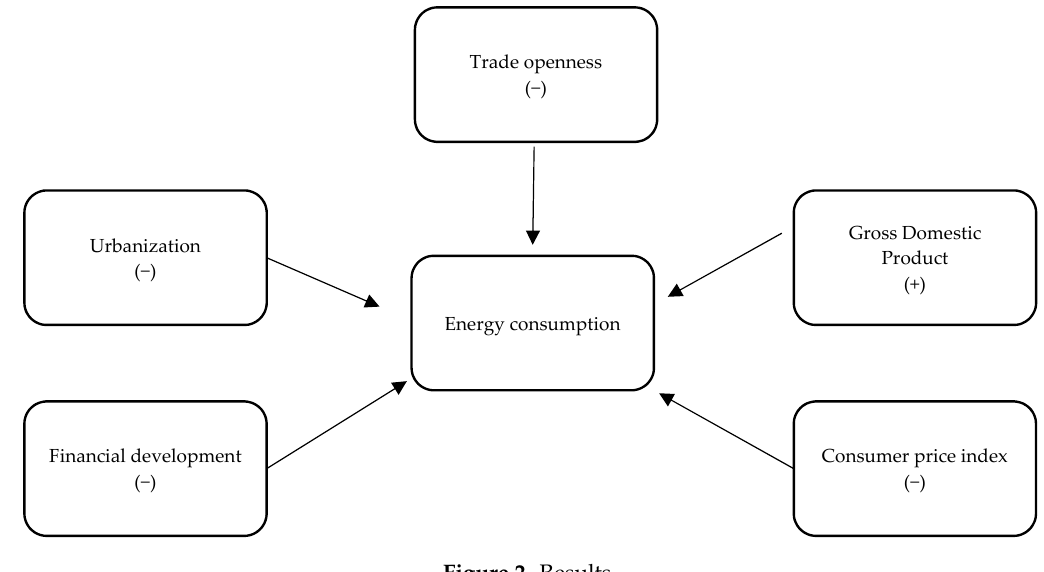
Figure 2. Results.